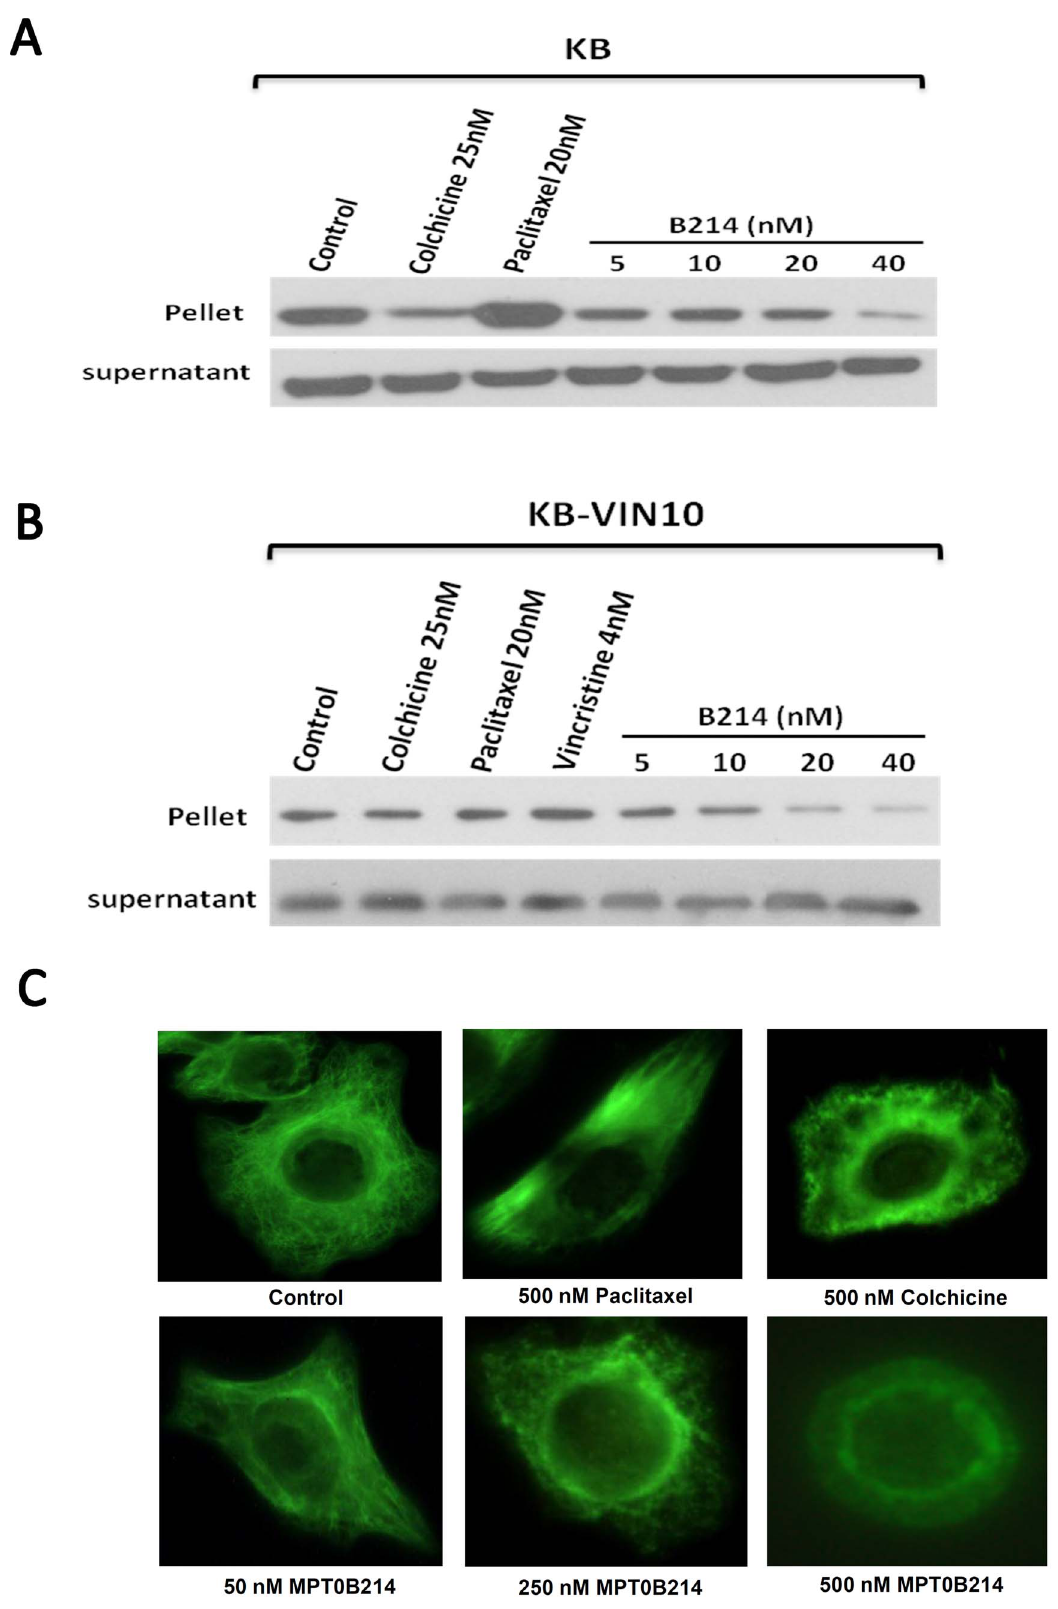
Figure 2. MPT0B214 inhibits microtubule assembly invivo . (A) KB and (B) KB-VIN10 cells were treated with test drugs or the same volume of DMSO in PBS as the control. After 24 h of incubation, cells were lysed in a lysis buffer. Cell lysates were centrifuged to separate polymerized microtubules (pellet) from tubulin dimmers (supernatant), as described in ‘‘Material and Methods’’. After gel electrophoresis and transfer to the